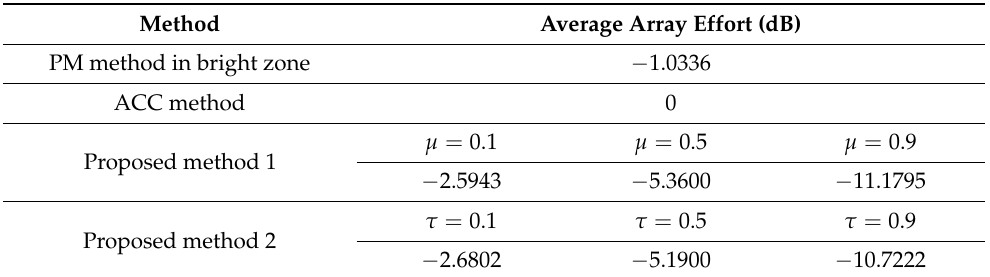
Table 5. Average array effort of different methods relative to frequency for two-dimensional experiment.